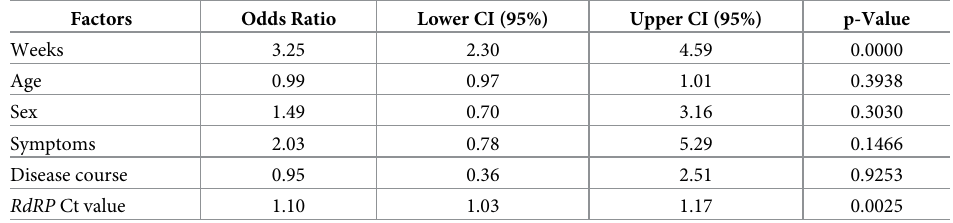
CI, confidence interval; Ct, cycle